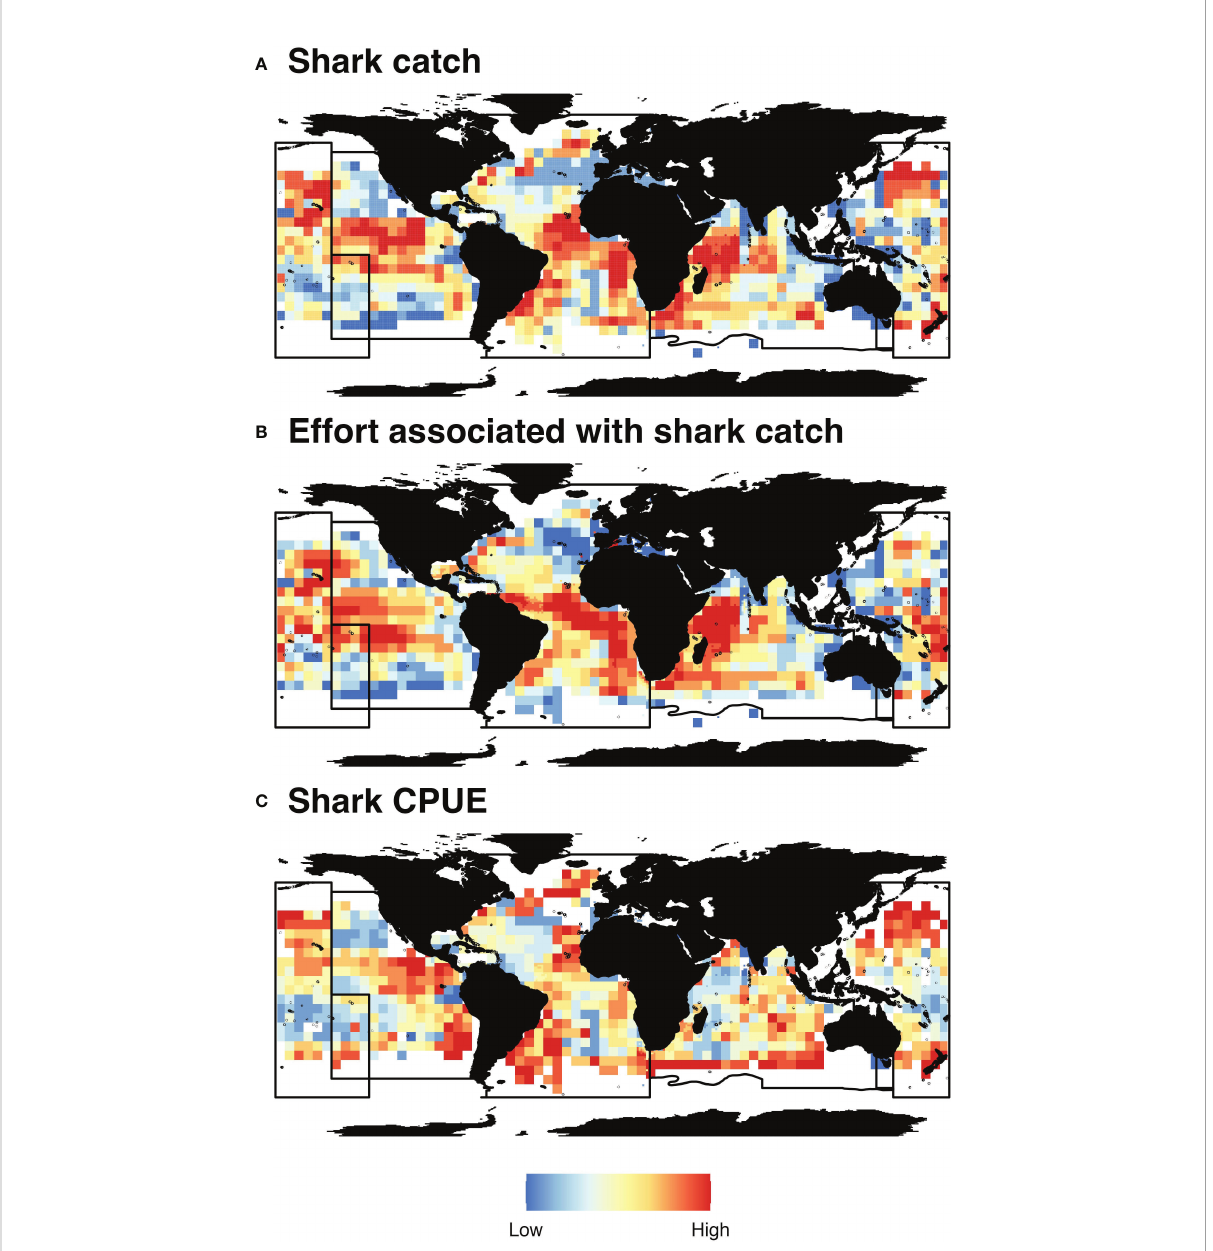
FIGURE 1 Spatial distribution of tRFMO catch and effort data. tRFMO mean annual shark catch (count, A ), effort associated with shark catch (hooks, B ) and shark CPUE (count/hook, C ) from publicly available longline data between 2012 – 2020. Data from each tRFMO were scaled independently using quantiles between 0 and 1 at 0.1 increments. Blue colors indicate areas of low shark catch, effort, and CPUE, while red colors indicate areas of high shark catch, effort, and CPUE. Black lines indicate tRFMO